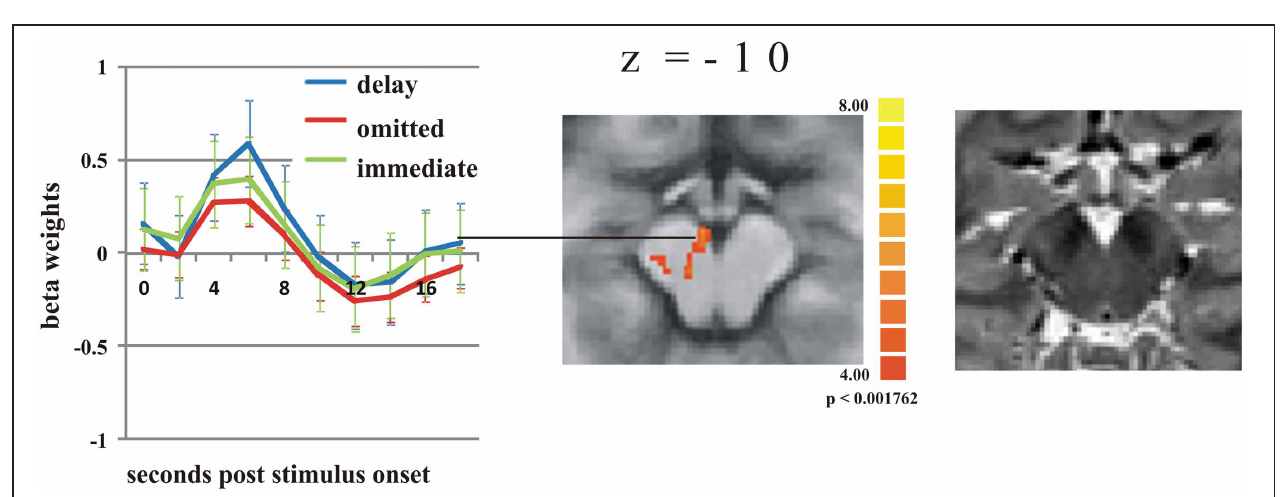
BOLD response in this cluster in response to delayed feedback (blue line), immediate feedback (green line), and omitted feedback (red line). Error bars indicate standard error of the mean (SEM).